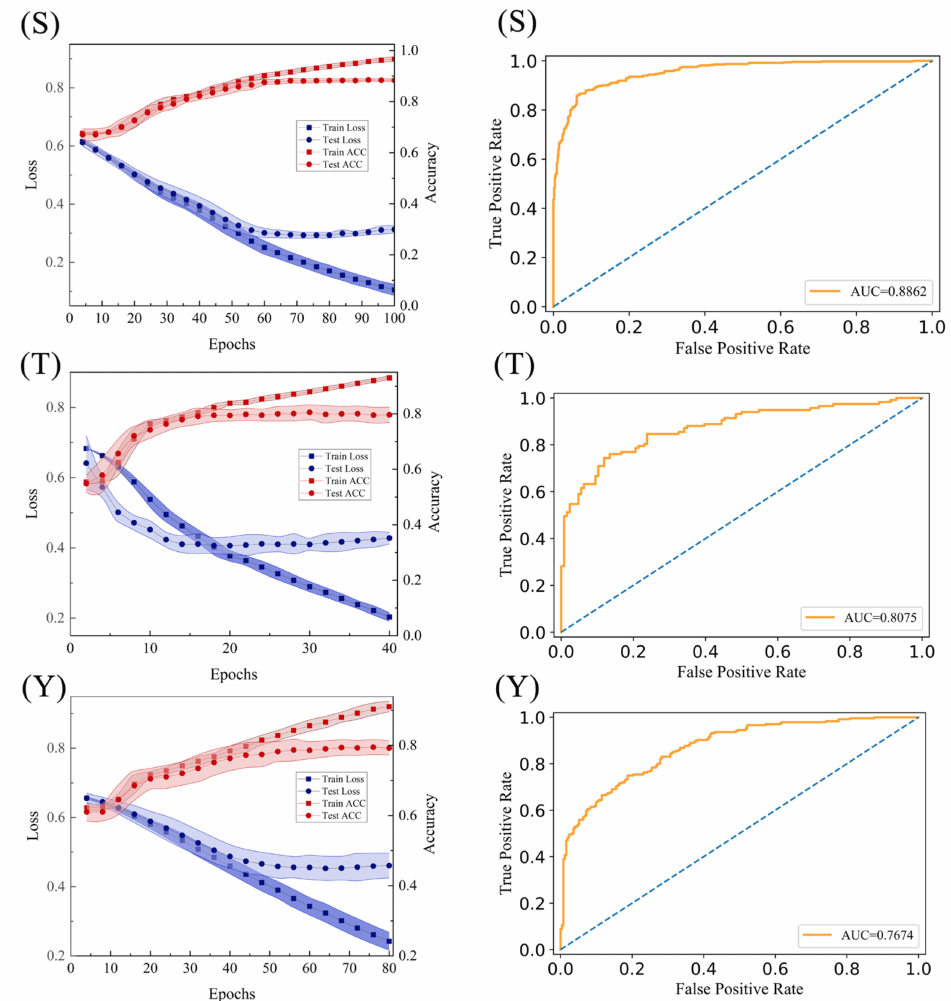
Figure 6. The learning curve and ROC curve of final diagnosis models. (S, T and Y) on the left column show the learning curves of the final model of S, T and Y datasets respectively; (S, T and Y) on the right column show the ROC curves of the final model of S, T and Y datasets